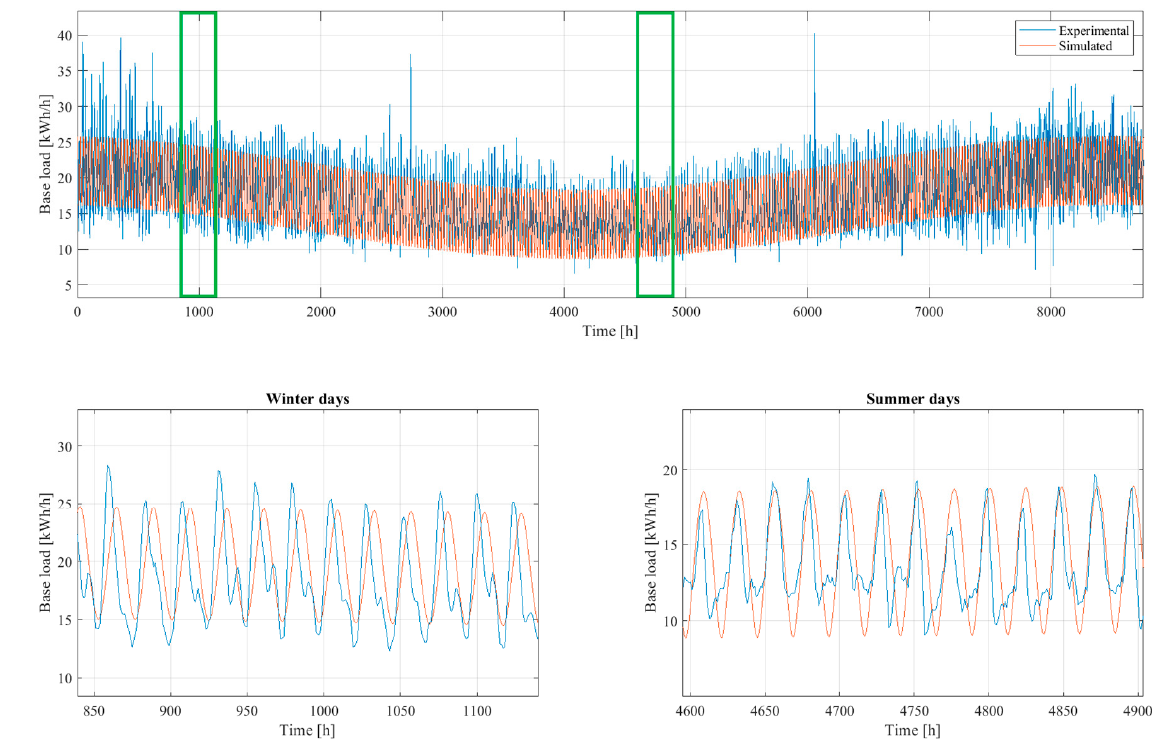
Figure 9. Base load for 2021. Comparison between the experimental data, measured at the car park, and the simulated data. A zoom in on the green squares is plotted for 13 winter days and 13 summer days. To ease the visualization of the results a moving average with 3 data points has been applied to the experimental data.